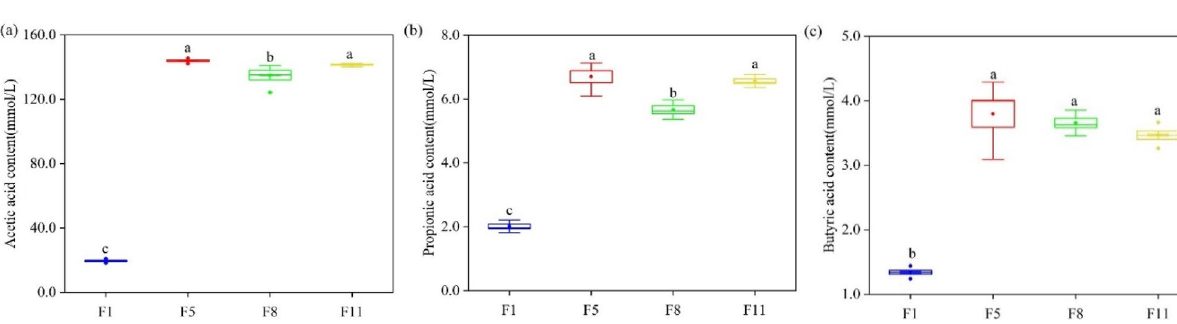
Figure 3. The ( a ) acetic acid, ( b ) propionic acid and ( c ) butyric acid content was measured at different culture